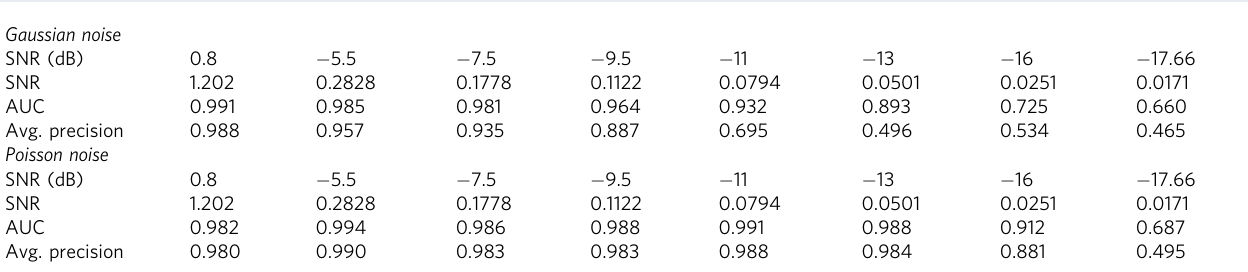
Table 1 The AUC and average precision scores for EMPIAR 10028 ( Plasmodium falciparum 80S ribosome bound to the anti- protozoan drug